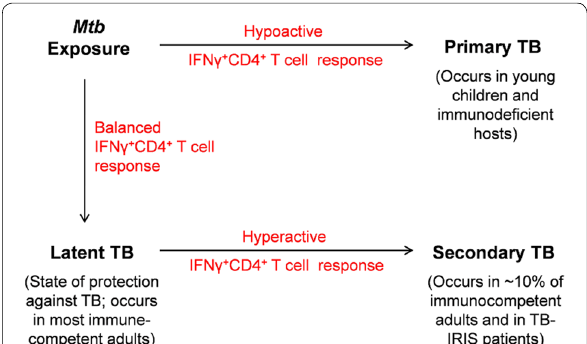
Fig. 1 Protective versus pathological role of IFNγ + CD4 + T cells during Mycobacterium tuberculosis ( Mtb ) infection. Mtb exposure in most young children and immunodeficient people evokes a hypoac- tive IFNγ + CD4 + T cell response, which is inefficient in containing the bacilli. Therefore, Mtb infection in these people results in primary TB, frequently affecting the extrapulmonary sites. In contrast, most of the immunocompetent adults mount a balanced immune response to Mtb and contain it in the form of latent TB. With the course of time, IFNγ + CD4 + T cell response would aggravate in nearly 10% of latently infected people, leading to the development of active TB in them. Similar aggravation of IFNγ + CD4 + T cells is to blame for TB–IRIS devel- opment in a subset of ART-treated, HIV- and Mtb -coinfected